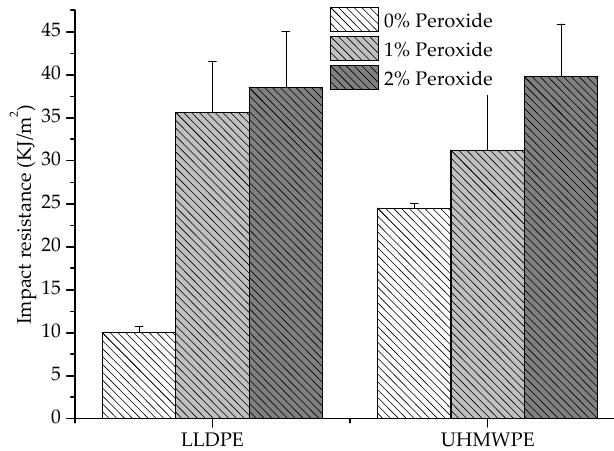
Figure 8. Resistance to the impact of LLDPE and UHMWPE with 1% and 2% peroxide. The degree of crosslinking of the samples was determined by the gel content, and the results are shown in Figure 9. We observed that with the addition of peroxide in the pol- yethylenes (LLDPE and UHMWPE), the percentage of gel content showed a small in- crease. Polyethylene crosslinking involves the decomposition of peroxide when two seg- ments of polymer molecules form a ‘cage’ around that molecule. The increase in the gel content achieved for UHMWPE in relation to LLDPE may be due to the higher entangle- ment density; it has a higher average molecular weight than LLDPE [37].